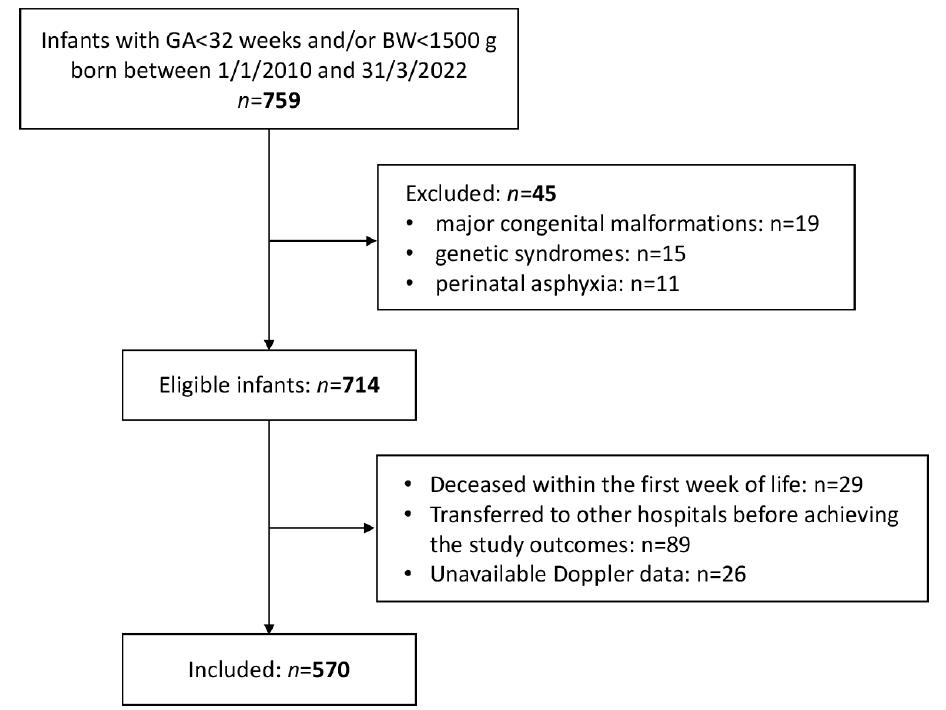
Figure 1. Flow-chart of the study